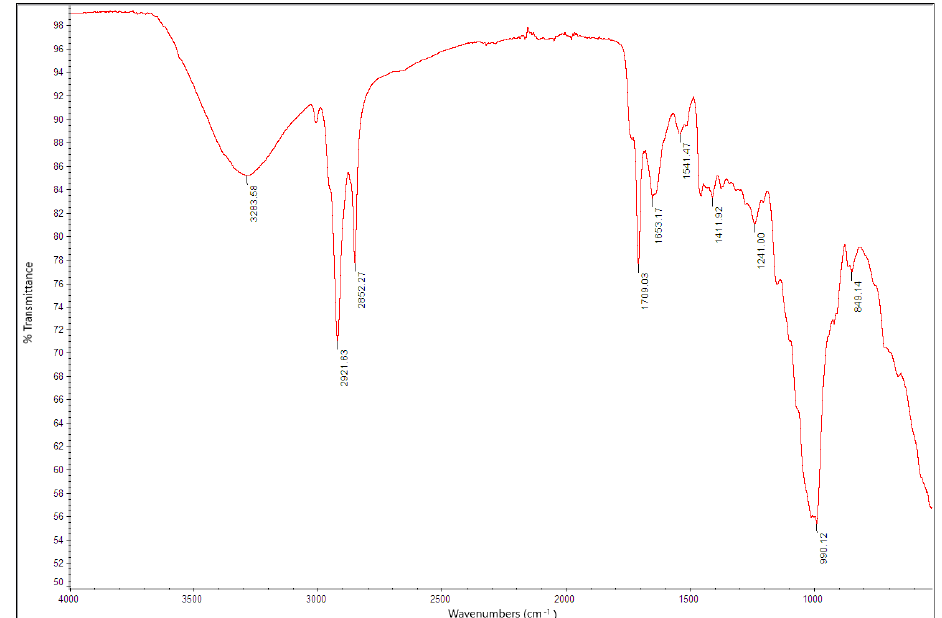
Figure 6. FTIR spectra of rice bran (own source) acquired at room temperature by a Nicolet FTIR iS10 spectrometer (Nicolet, Madison, WI, USA) equipped with Smart iTR with diamond plate on Carnaroli rice bran. The waste was dried at 45 °C before analysis. Thirty-two scans in the 4000–600 cm − 1 range at 4 cm − 1 resolution were coadded. The peaks are indexed by the tool “Find Peaks” in the Omnic Spectra software.